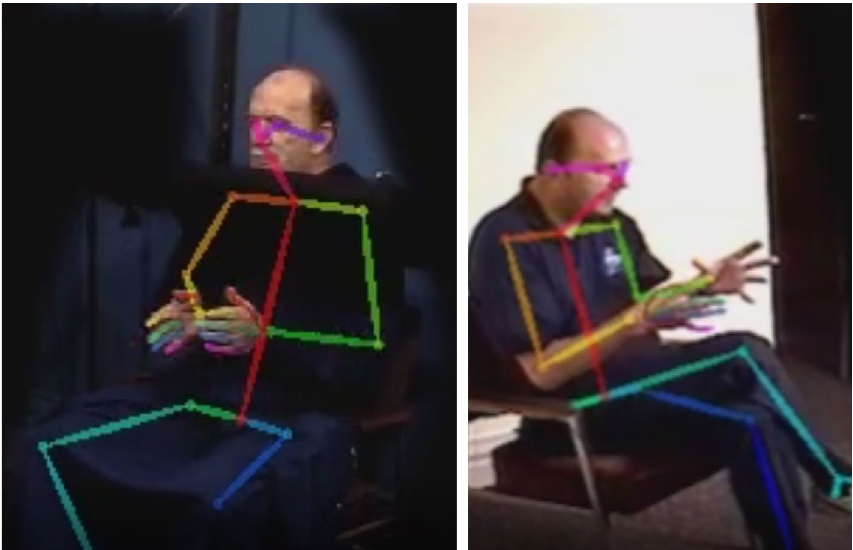
Figure 1. Example pose estimation from video-recordings. Note . Example of the 2002 (left panel; blind condition) and 1998 (right panel; no blind condition) experiment wherein we superimposed pose tracking skeleton extracted with